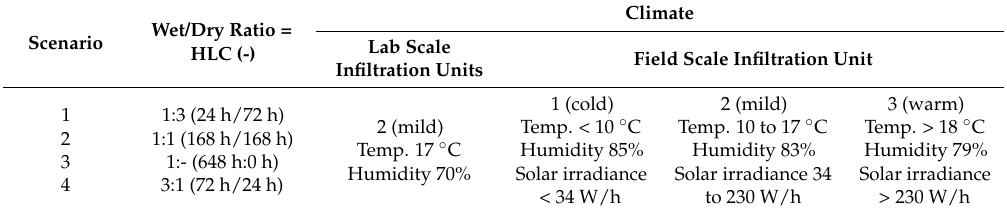
Table 1. Boundary conditions in the experimental units during the infiltration scenarios. Wet/Dry Ratio = Scenario HLC (-)